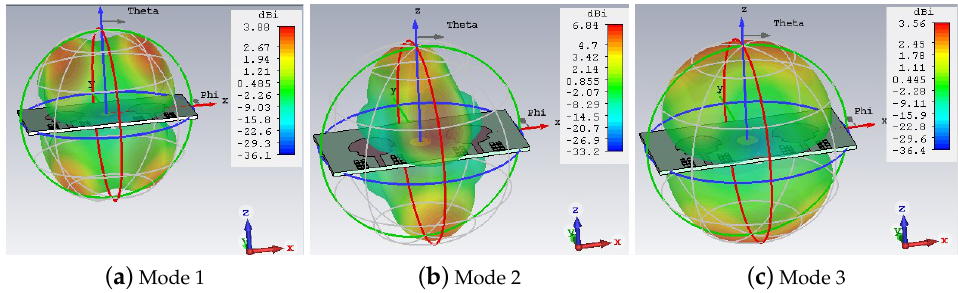
Figure 18. Normalized 3D radiation pattern of three modes at 5.2 GHz.